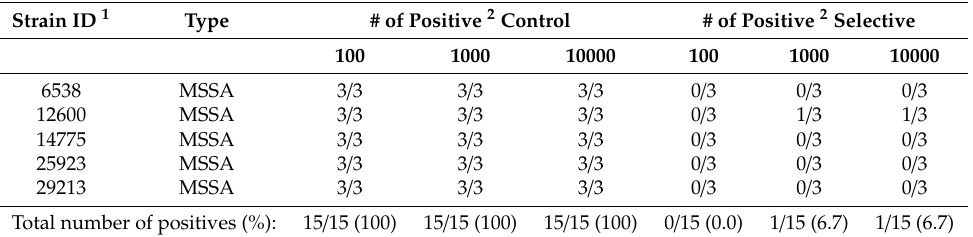
Table 2. In Vitro discrimination of methicillin-susceptible Staphylococcus aureus (MSSA).